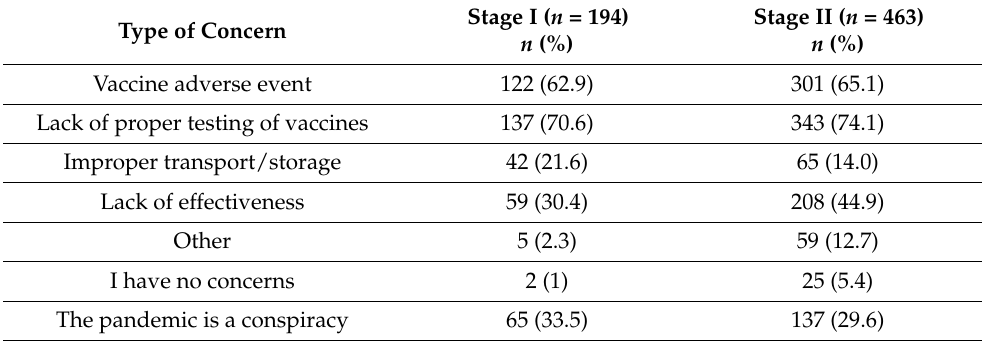
Table 4. List of concerns related to vaccination of persons who do not wish to get vaccinated. Type of